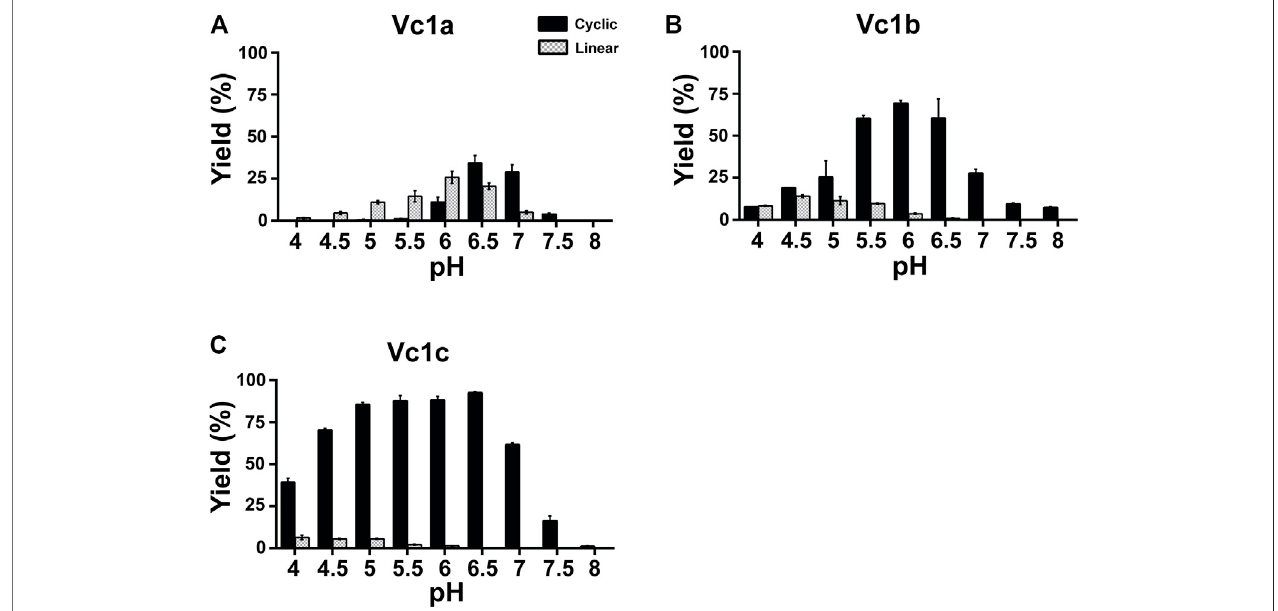
FIGURE 4 | pH-dependent cyclization ef fi ciency of VcAEP and mutants. (A – C) Quantitative summary of VcAEP mutant Vc1a-Vc1c product yield analyzed using MALDI-TOF mass spectrometry. Gray and black bars indicate the percentage yield of linear product and cyclic product, respectively. The reactions were conducted at 37 ° C for 15 min with a molar enzyme:substrate ratio of 1:200 (Vc1a), 1:500 (Vc1b), and 1:1000 (Vc1c). Average yield and SDs were calculated from experiments performed in triplicate.